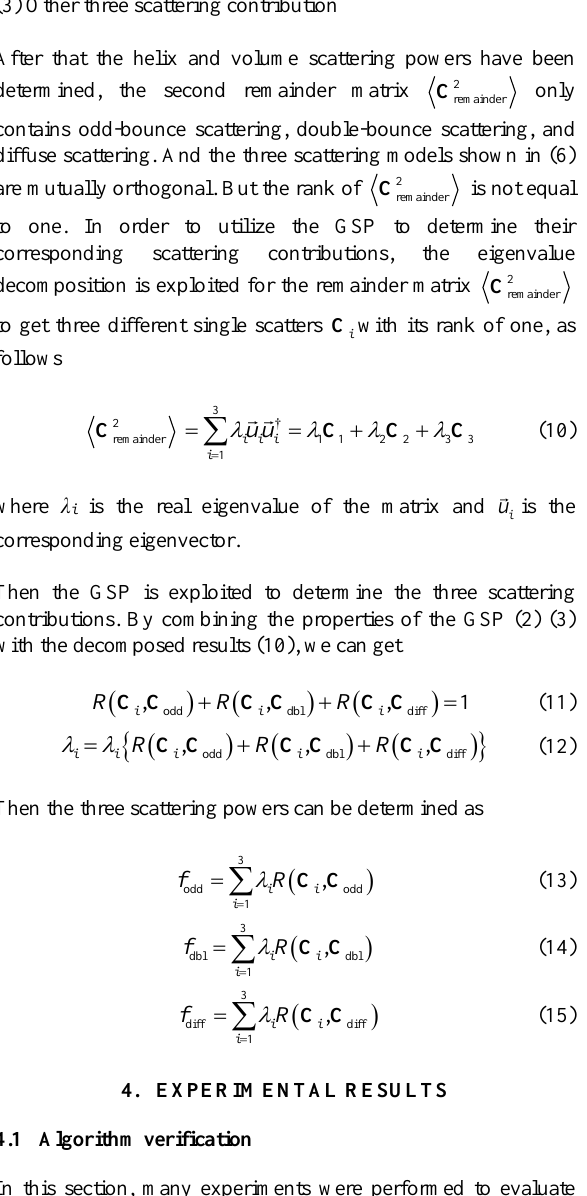
Table 1. The main acquisition parameters